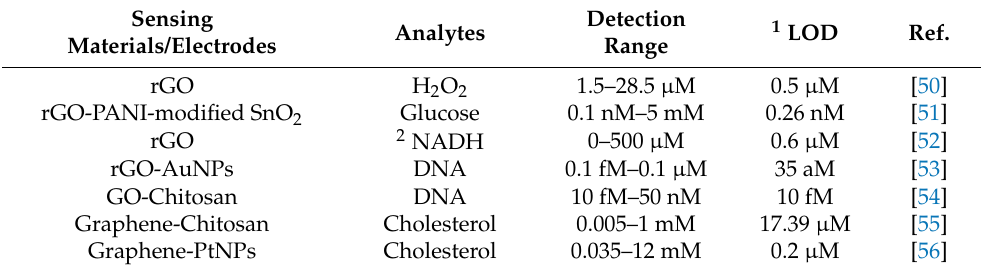
Table 1. Performance between graphene and graphene derivatives in